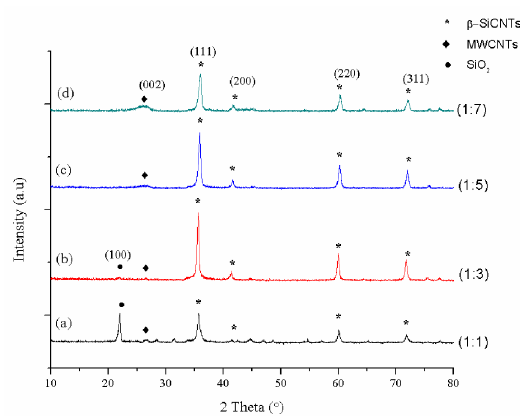
Figure 3. XRD patterns of SiCNTs synthesized from blend of SiO and MWCNTs in the ratio of a) 1:1; b) 1:3; c) 1:5 and d) 2